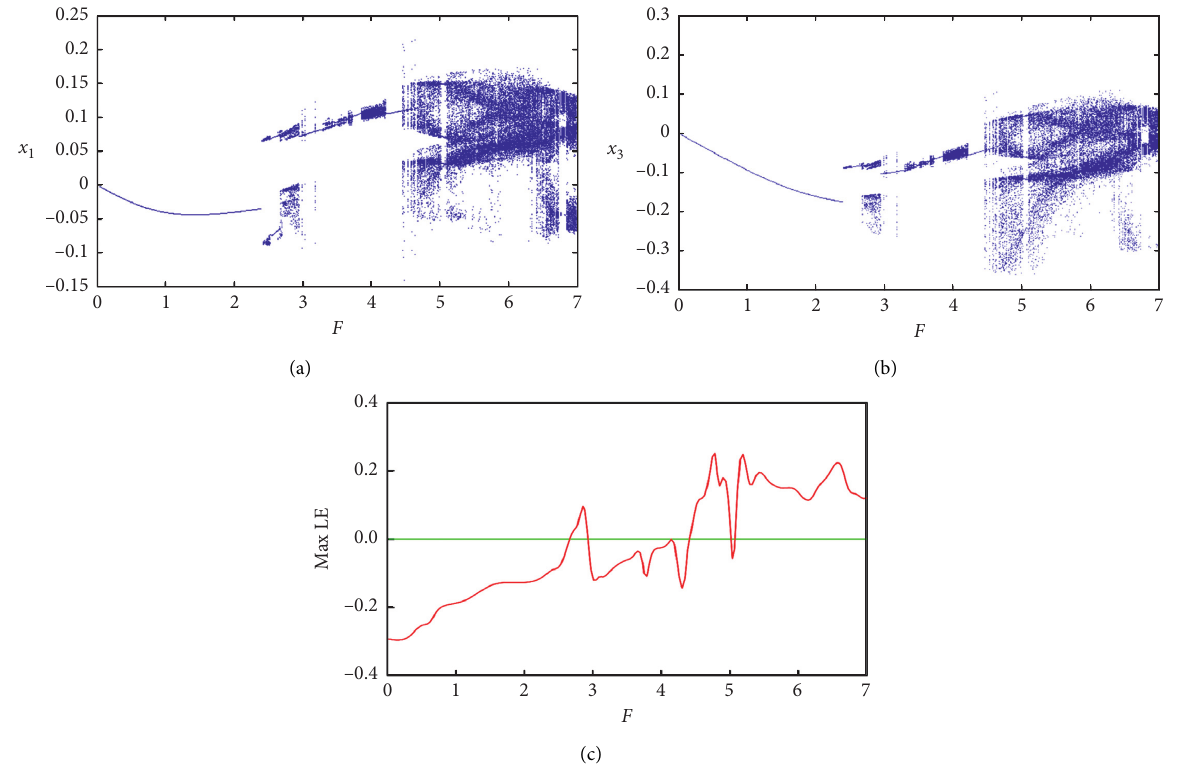
Figure 8: The bifurcation diagrams and maximum Lyapunov exponents of the cantilevered pipe conveying pulsating fluid are obtained for the external excitations when the flow velocity is U maximum Lyapunov exponents versus flow